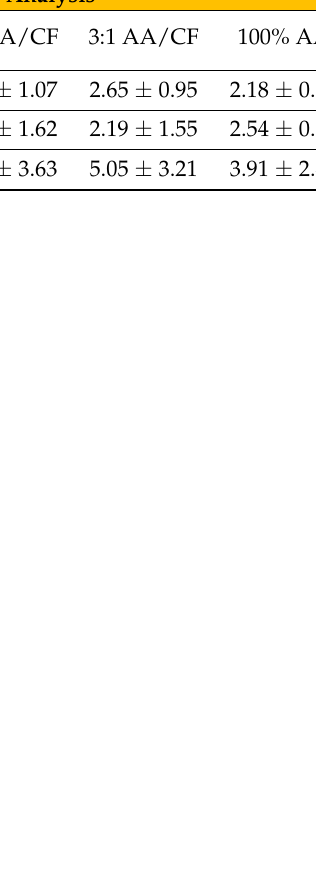
Figure 3. Mean particle diameters (in µm) and respective standard deviations for all the groups tested based on the SEM micrographs.